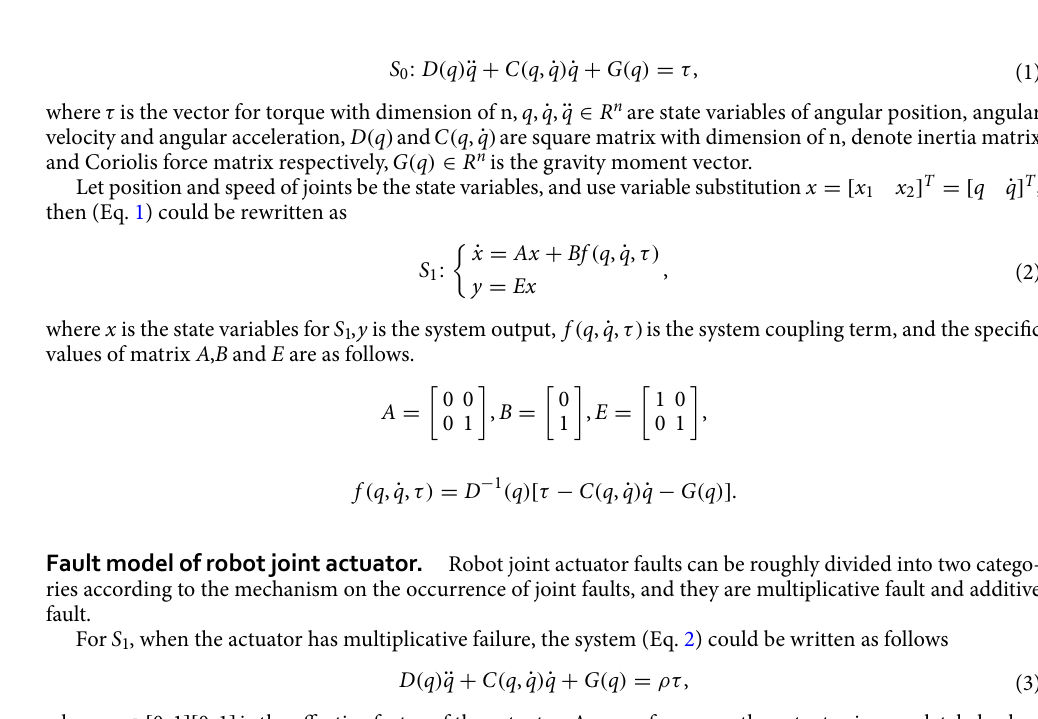
Table 1. Actuator fault type